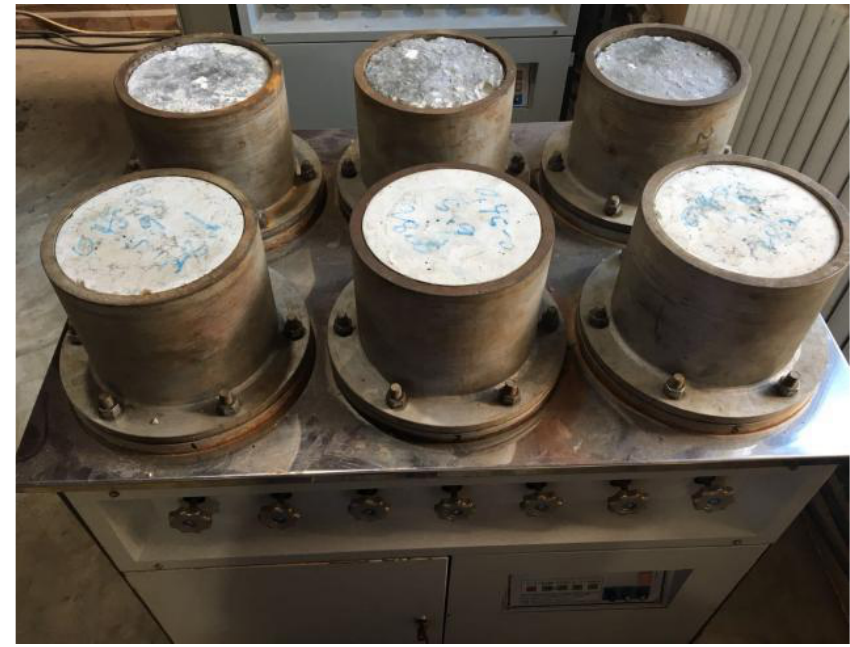
Figure 3. Water resistance test pieces.